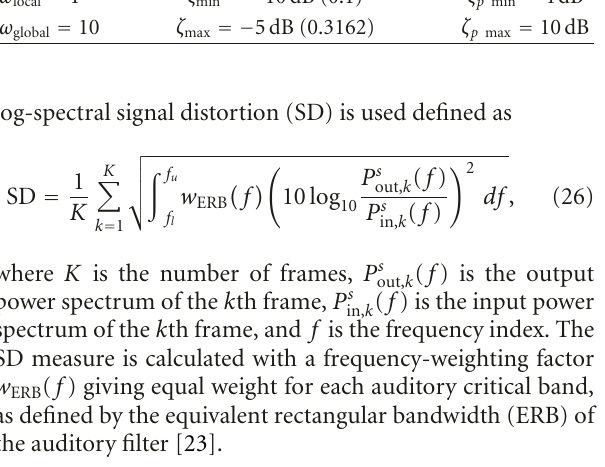
Figure 11: Conditional SPP for the combined solution with two distinct speech dominant segments. Table 1: Parameters used for the estimation of the conditional SPP. β = 0 . 7